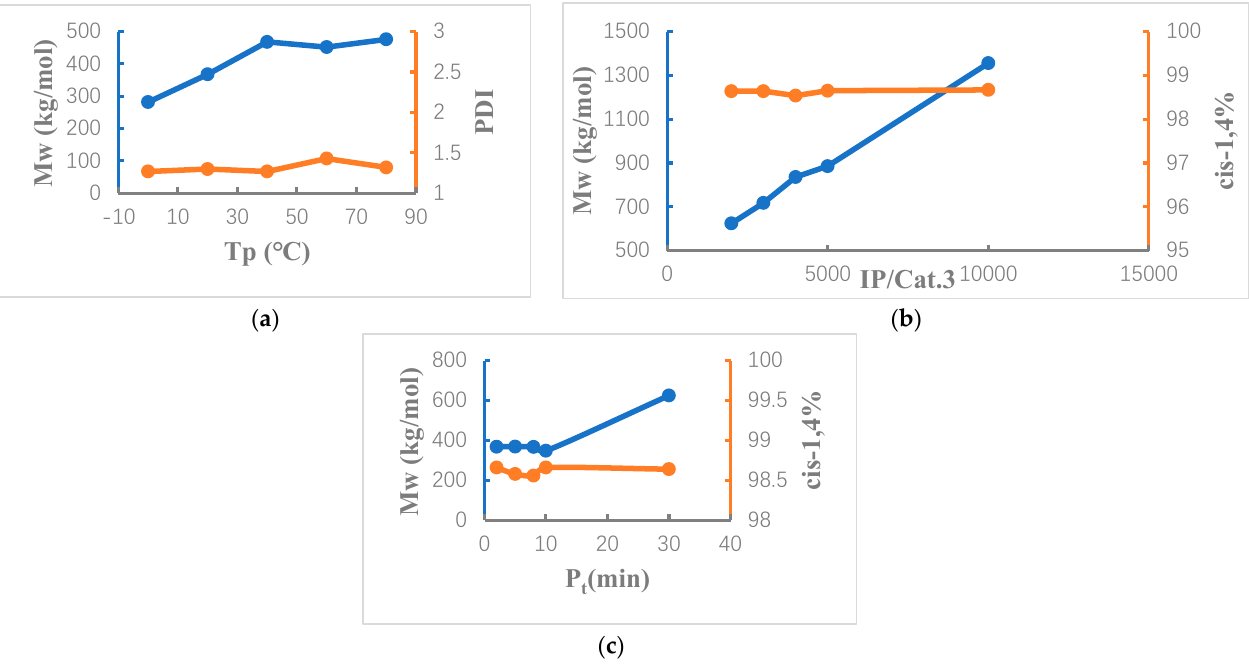
Figure 3. Polymerization temperature, IP/Re ratio and reaction time influence; ( a ) reaction temperature to Mw and DPI influence; ( b ) IP/3 ratio to Mw and stereoselectivity influence; ( c ) reaction time to Mw and stereoselectivity influence.